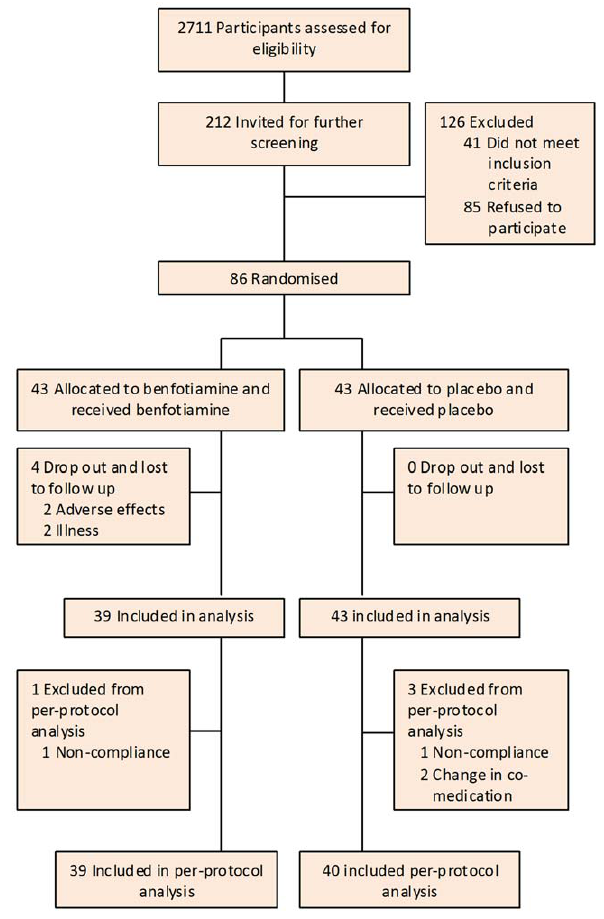
Figure 1. CONSORT flow diagram of the study.